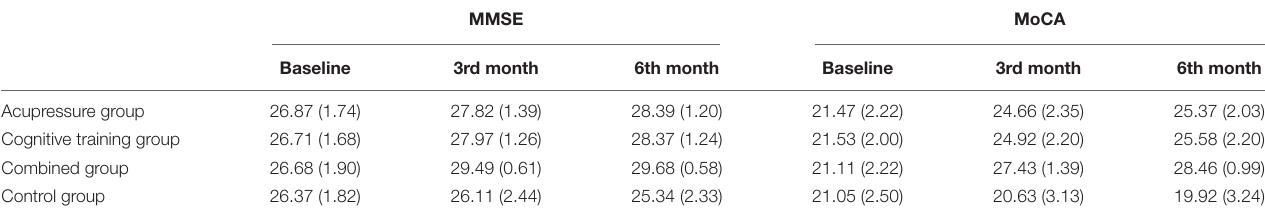
TABLE 3 | Mean scores of MMSE and MoCA of the four groups at each time